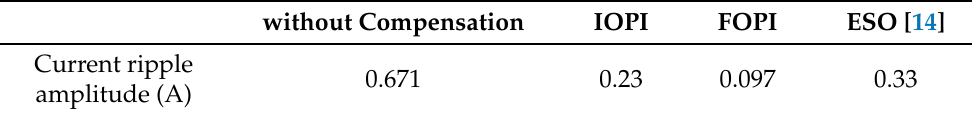
Table 6. The performance index comparison of I d step current response.